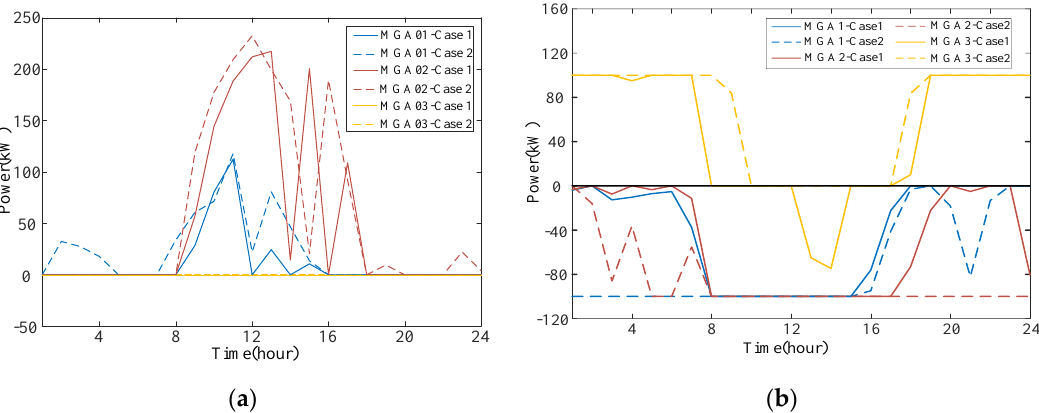
Figure 4. Variation in the MMG system with and without coordination. They are listed as: ( a ) Changes of renewable energy curtailment ( b ) Changes of power exchange with the main grid.